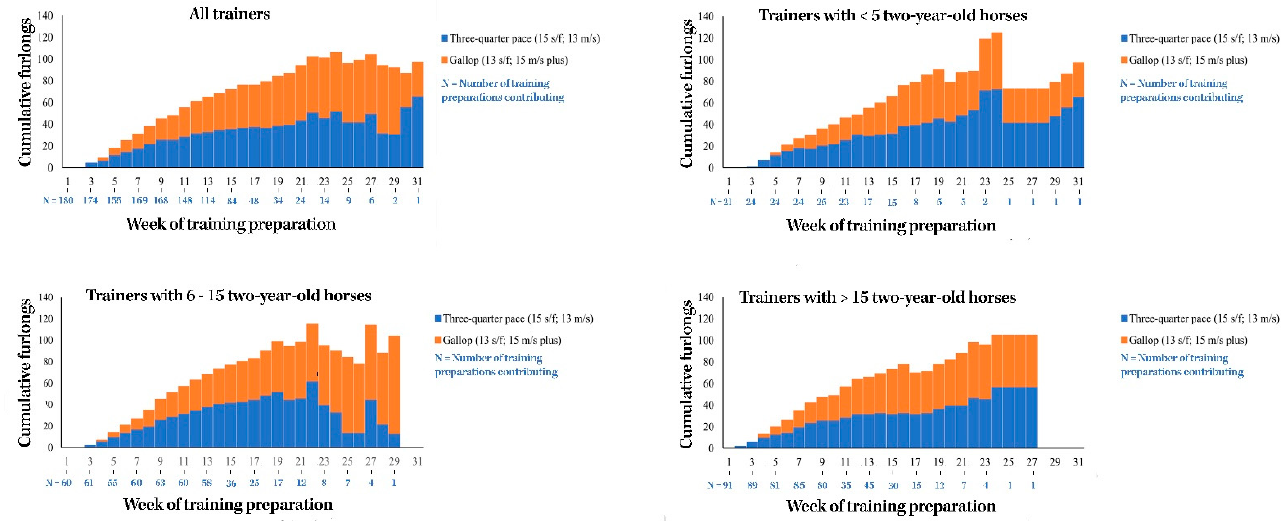
Figure 2. The median cumulative weekly high-speed exercise training volumes for two-year-old Thoroughbred racehorses after their first official race trial in Queensland, Australia.